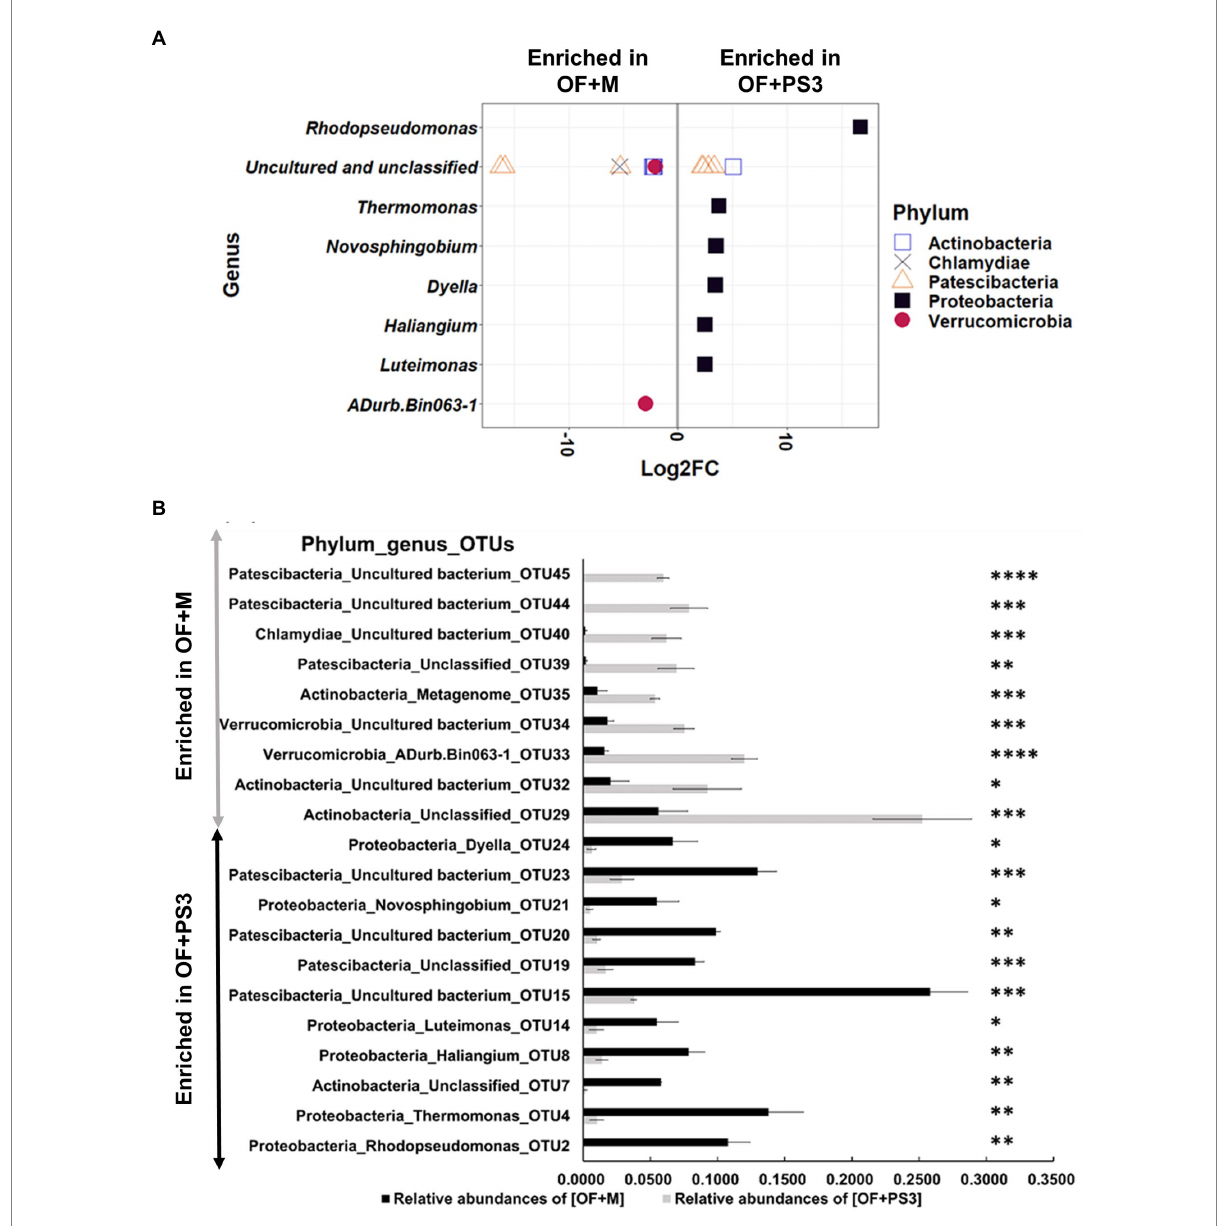
FIGURE 6 Pairwise comparison. (A) Differential abundant of selected OTUs Log 2 -fold change of differentially abundant selected OTUs between the OF + M and OF + PS3 treatments at the phylum and genus levels ( p < 0.05 and relative abundances >0.05%). OTUs were assigned to genus ( y -axis) and phylum levels (colors and shapes). Log 2 FC represented as Log 2 -fold change. Negative “Log 2 FC” values ( x -axis) indicate higher abundance in OF + M samples, and positive values indicate higher abundances in OF + PS3 rhizosphere OF + M: (B) Relative abundances of selected individual OTUs in OF + M and OF + PS3 treatments ( p < 0.05). OF +M: bar in gray, noninoculated control; OF + PS3: bar in black, the inoculation treatments with strain PS3. Significant difference in the relative abundances ( ≥ 0.05) of samples based on permutation T -test (ns, p > 0.05; * p < 0.05, ** p < 0.01,